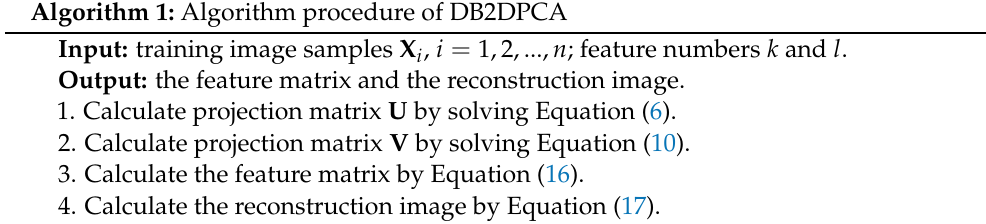
Algorithm 1: Algorithm procedure of